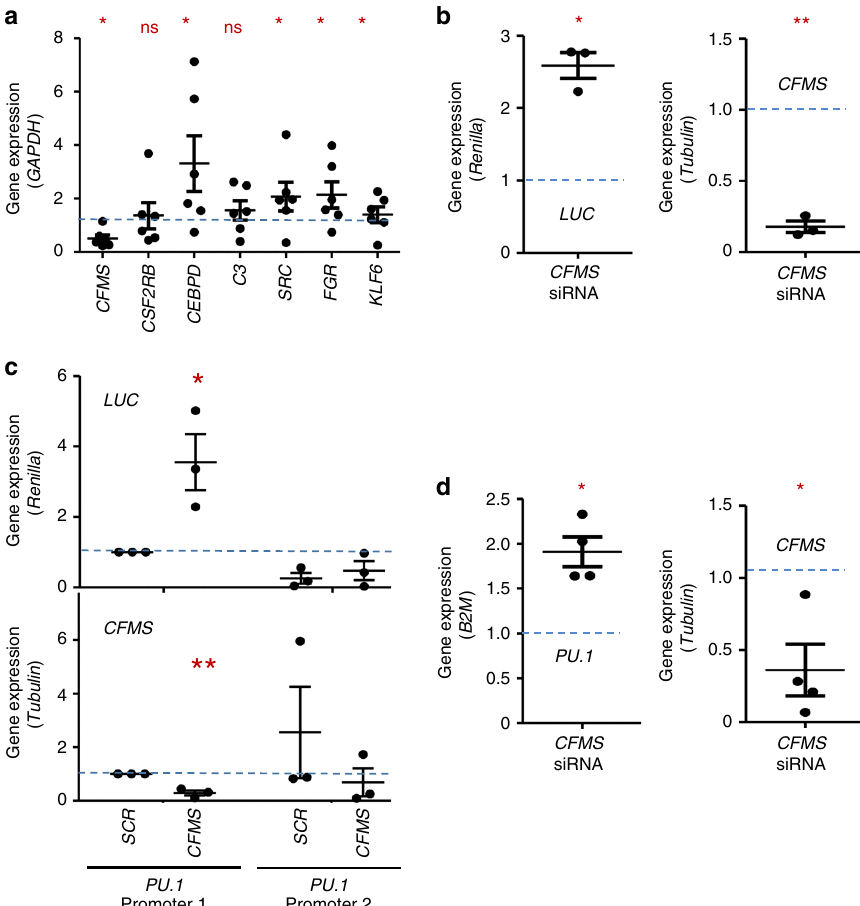
Fig. 5 CSF-1R negatively regulates PU.1 gene expression in human monocytes. a The expression of indicated genes was measured by RT-qPCR in monocytes transfected 72 h before with a scramble ( SCR ) or a CFMS speci fi c siRNA (mean + / − SEM of 6 independent experiments, results in CFMS - siRNA transfected cells normalized to SCR -siRNA = blue hatched line; Mann – Whitney test: * P < 0.05; ns, non signi fi cant). b Expression of LUCIFERASE (LUC , normalized to Renilla) and CFMS (normalized to TUBULIN ) genes in monocytes, 48 h after transfection with a scramble ( SCR ) or a CFMS speci fi c siRNA and PGL4.17-EGR1 motif plasmid (mean + / − SEM of 3 independent experiments, results in CFMS -siRNA transfected cells normalized to SCR -siRNA = blue hatched line; Paired t test: * P < 0.05, ** P < 0.01). c Expression of LUCIFERASE (normalized to Renilla ) and CFMS (normalized to TUBULIN ) in monocytes 48 h after transfection with SCR or CFMS speci fi c siRNA and PGL4.17-PU1 promoter 1 (complete) or PGL4.17-PU1 promoter 2 (deleted of